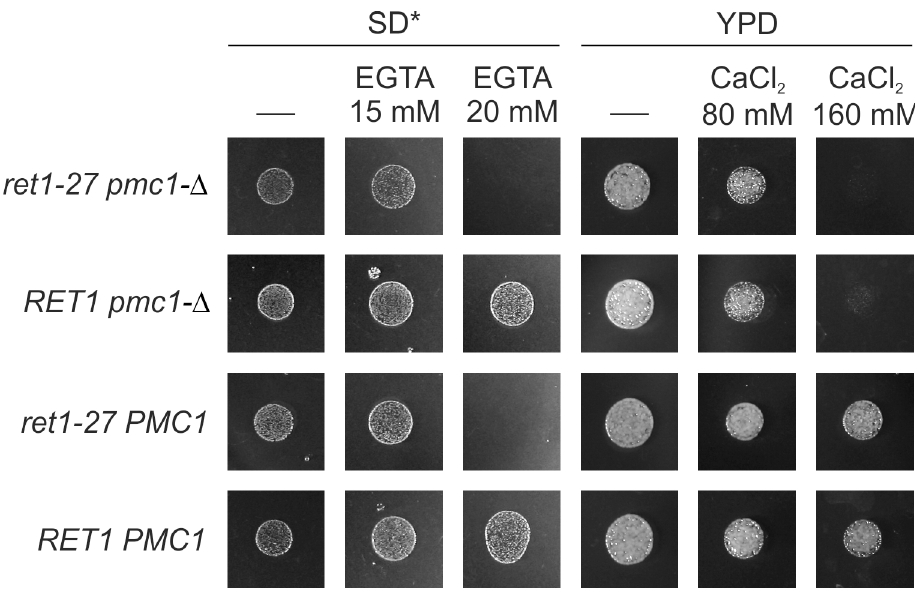
Fig 5. Sensitivity of the ret1-27 pmc1- Δ double mutant to a shortage or excess of Ca 2+ in culture medium. Cell suspensions with equal densities were spotted onto corresponding media and grown for 2 days. Ca 2+ shortage was achieved by addition of EGTA to SD * medium. Excess of Ca 2+ was achieved by supplementing YPD with CaCl 2 . The experiment was repeated with serially diluted cell suspensions (S7 Fig). ret1-27 pmc1- Δ , the 64MA70QA- Δ pmc strain; pmc1- Δ , the 64MA70Q-RET- Δ pmc strain; ret1-27 , the 64MA70QAL strain; WT, the 64MA70QL-RET